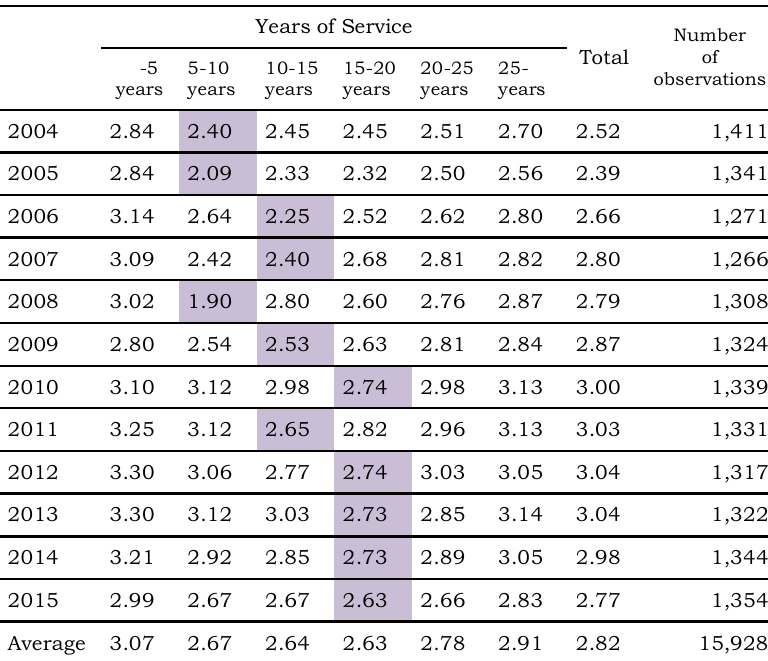
Table 1. Years of service and perspective index